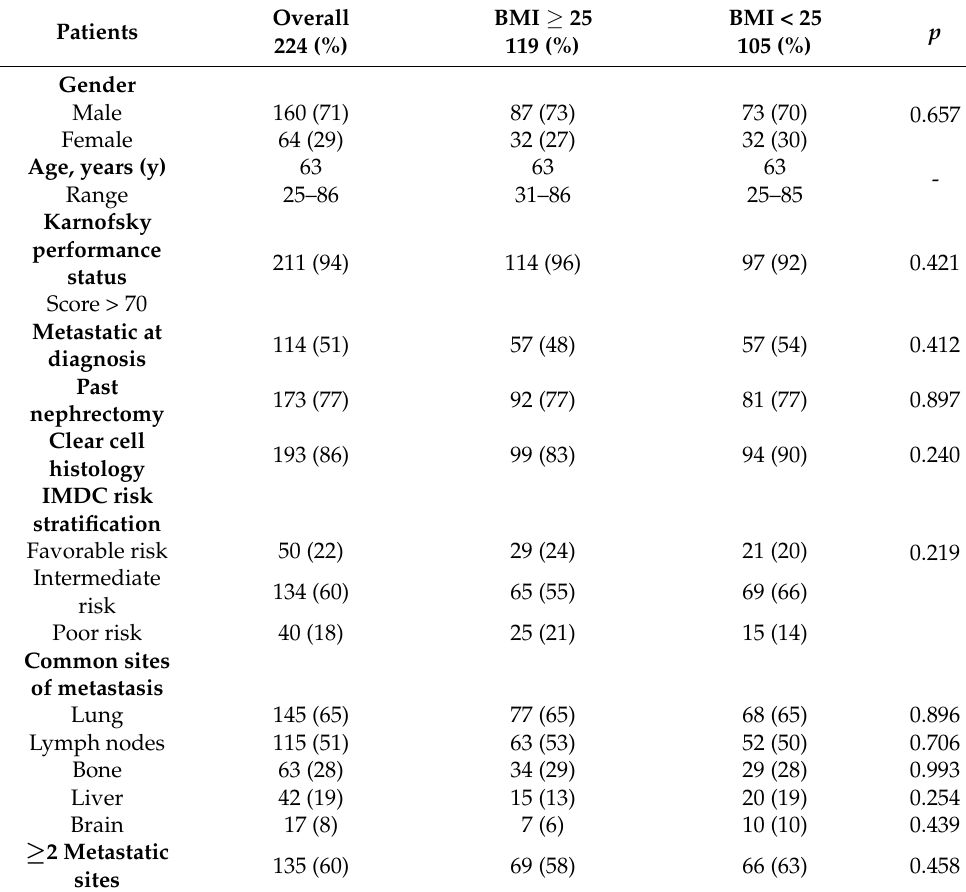
Table 1. Patient demographic and disease characteristics. BMI: body mass index; IMDC: International Metastatic Renal Cell Carcinoma Database